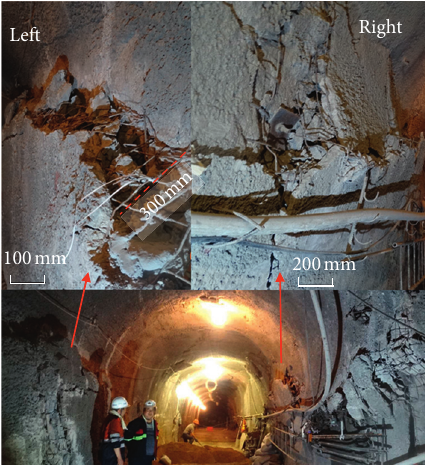
Figure 1: Large area of extrusion cracking on the sidewall of the deep tunnel.